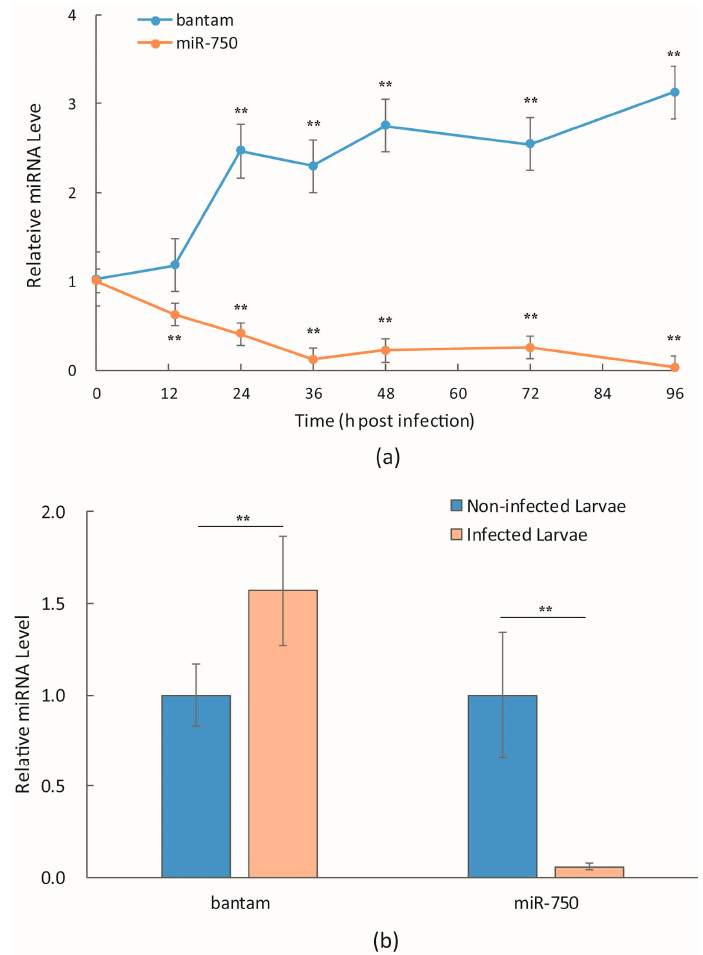
Figure 1. Expression level of microRNA bantam in AcMNPV-infected Sf9 cells and Spodoptera litura larvae. Total small RNA samples were prepared from infected Sf9 cells at different time points ( a ), or infected S. litura larvae (4 d p.i.) ( b ). The levels of microRNA bantam and miR-750 were determined with real-time RT-PCR using U6 RNA as the internal control. The fold change comparing to the non-infected control was shown. The means of three or more replicates were shown, with the error bars indicating the standard deviation. The significance of difference between certain time point and 0 h ( a ), or between infected and non-infected larvae ( b ), was also shown (*: p < 0.05; **: p < 0.01).